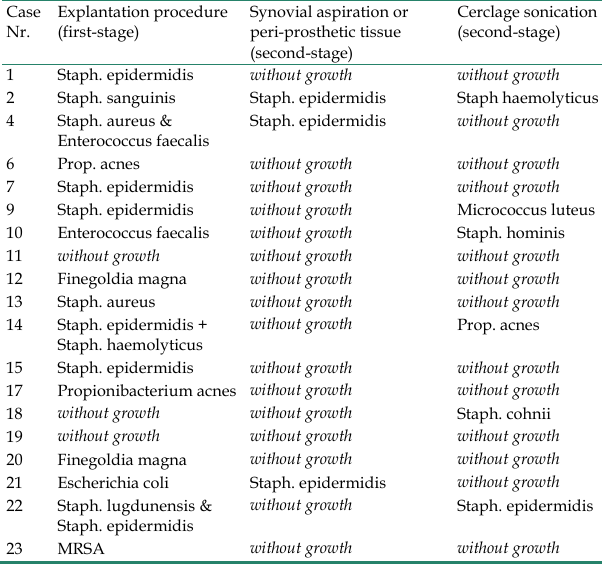
Table 1: Overview over the microbiological culture results of the first-stage explantation and second-stage reimplantation procedure for patients undergoing two-stage septic THA exchange.